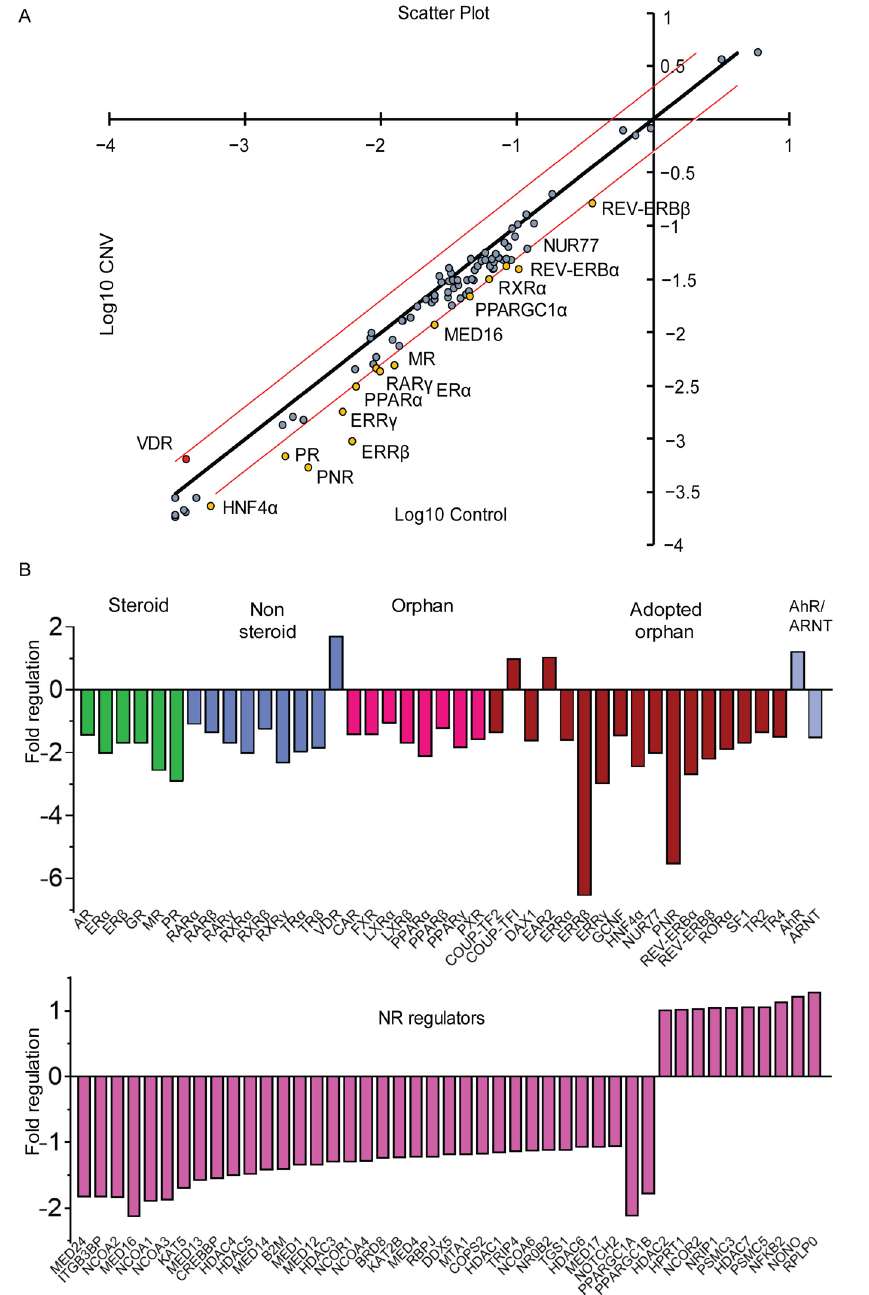
Figure 7. Nuclear receptor expression in the choroid of age laser induced CNV mice. ( A ) Scatter plot showing gene expression changes of nuclear receptors and co-regulators in lasered mice as compared to control group. The scatter plot compares the normalized expression of every gene on the PCR array between the two selected groups by plotting them against one another to visualize large gene expression changes. The center diagonal line indicates unchanged gene expression, while genes with red data points above in the upper left and yellow data points in lower right corners are up-regulated or down-regulated, respectively by more than 2-fold regulation threshold in the y-axis CNV Group relative to the x-axis Control Group. Grey data points represent within 2-fold cutoff threshold indicated by red lines. ( B ) Fold regulation of genes in CNV laser versus control mice using ∆∆ CT method. Fold regulation of genes are categorized into different nuclear receptor classes like steroid hormone receptor, non-steroid hormone receptor, orphan receptors and adopted orphan receptors. NR = nuclear